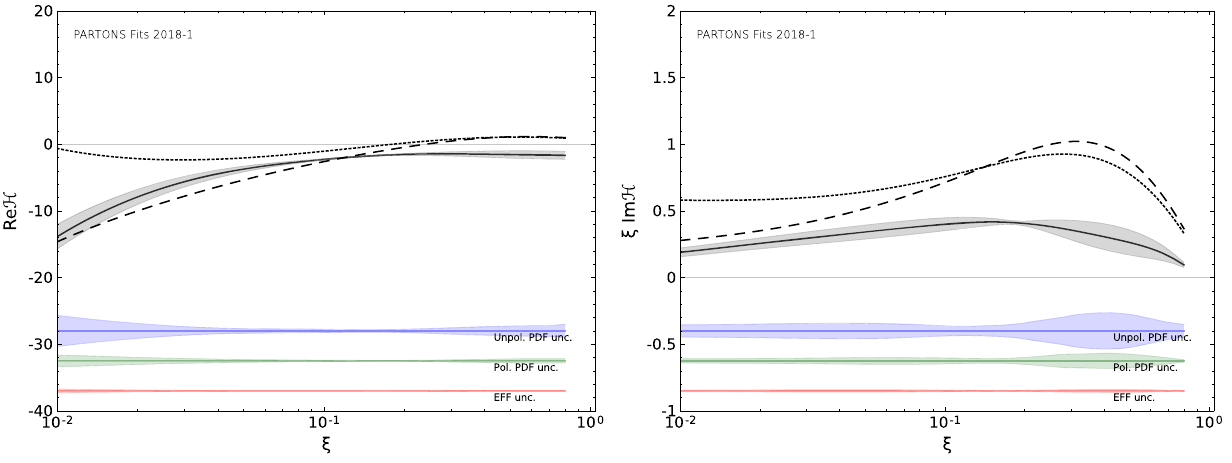
Fig. 11 Real (left) and imaginary (right) parts of the CFF H obtained in this work as a function of ξ at t = − 0 . 3 GeV 2 and Q 2 = 2 GeV 2 . For further description see Fig. 6